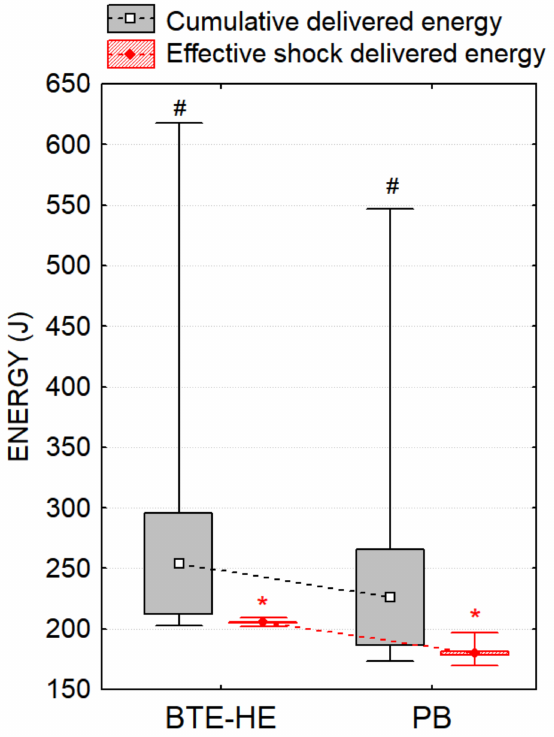
Figure 3. Comparison of BTE-HE and PB waveforms in respect to the delivered energies during CVS: cumulative delivered energy (primary endpoint), delivered energy of the effective shock (secondary endpoint). Plots indicate mean ± 95% CI (box) and min–max range (whiskers). Markers: # p = 0.31— Non-inferiority result was proven for the cumulative delivered energies; * p < 0.001—Significantly lower delivered energy of the effective shock was found for the PB